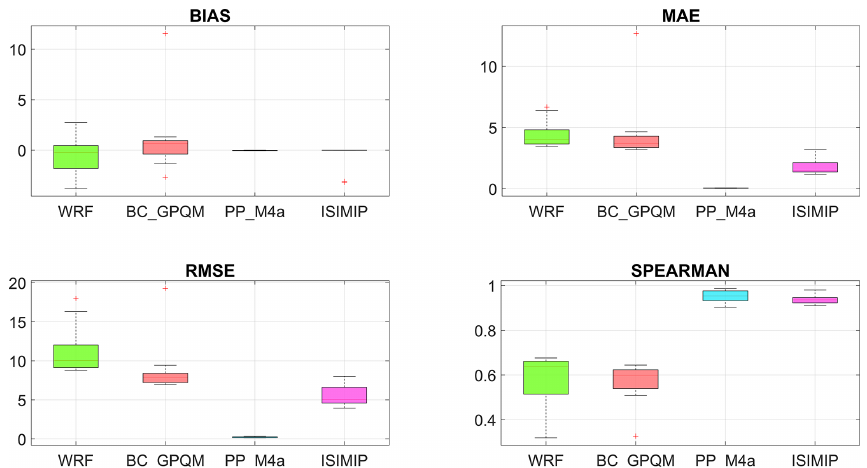
Figure 3. Precision and reliability indicators. Bias (mm), MAE (mm), RMSE (mm), and Spearman correlation coefficient. WRF is the uncorrected model, while the other models are the different methodologies used for correction by MeteoLab. Table 2. Values of the estimators for the logit models. False-positive rate (FPR) and true-positive rate (TPR) were evaluated with a threshold of 95%. Intercept Daily precipitation 7d 30d Slope FPR TPR accumulated accumulated precipitation